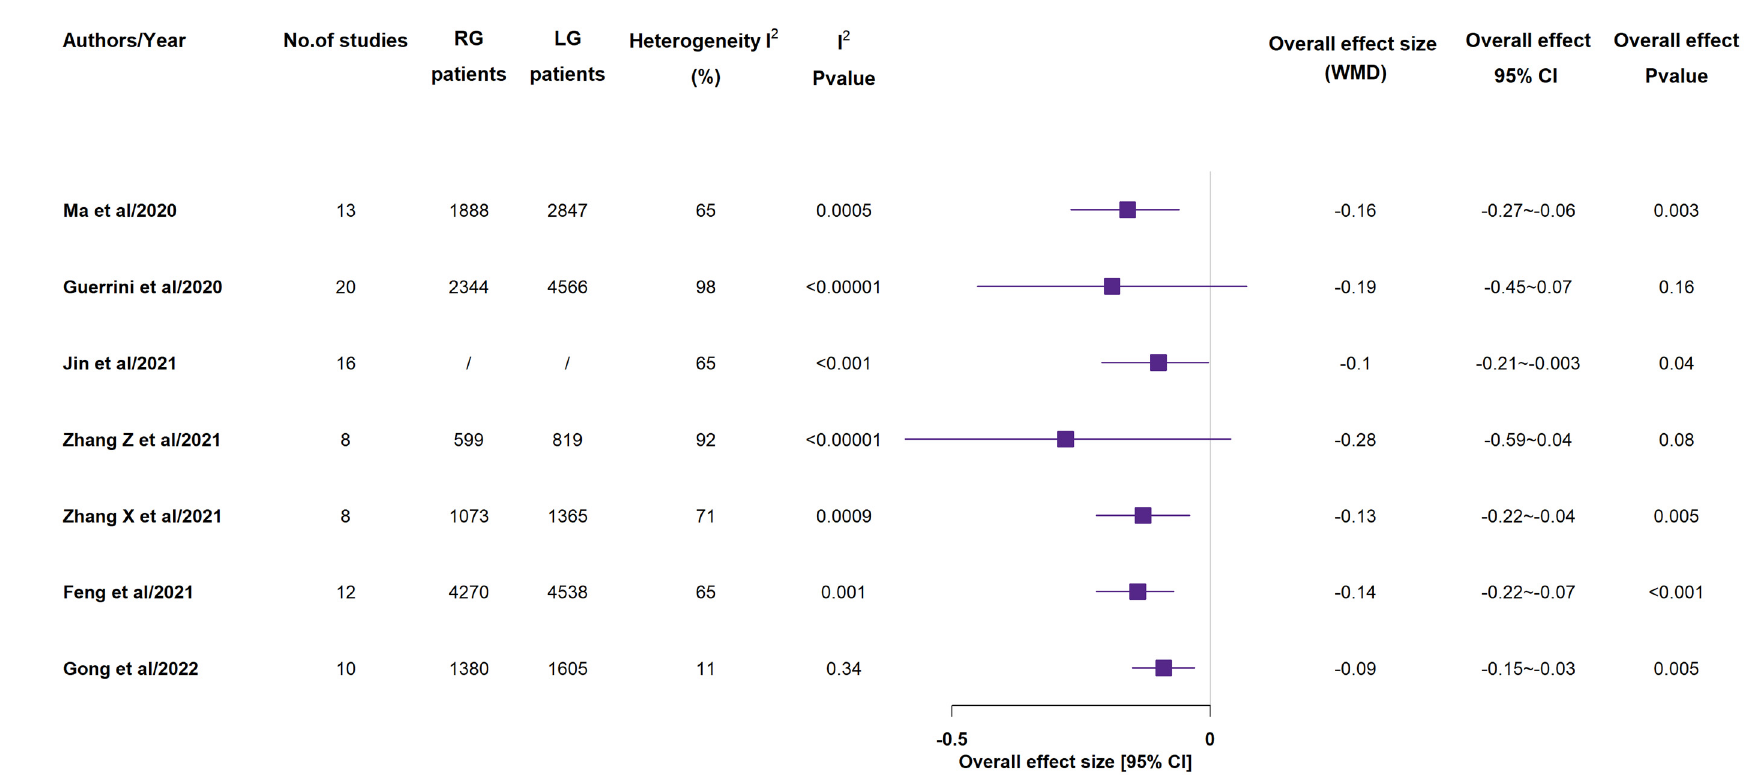
Figure 5. Time to first flatus (days). RG = Robotic gastrectomy; LG = Laparoscopic gastrectomy; WMD = weighted mean difference